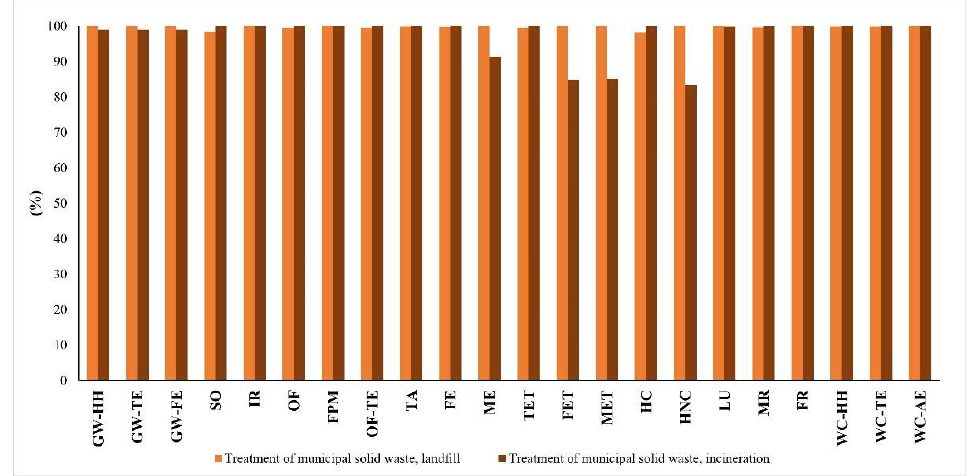
Figure 4. Comparative relative environmental impacts of CD-5 for incineration and landfill disposal scenario, applying ReCiPe method.